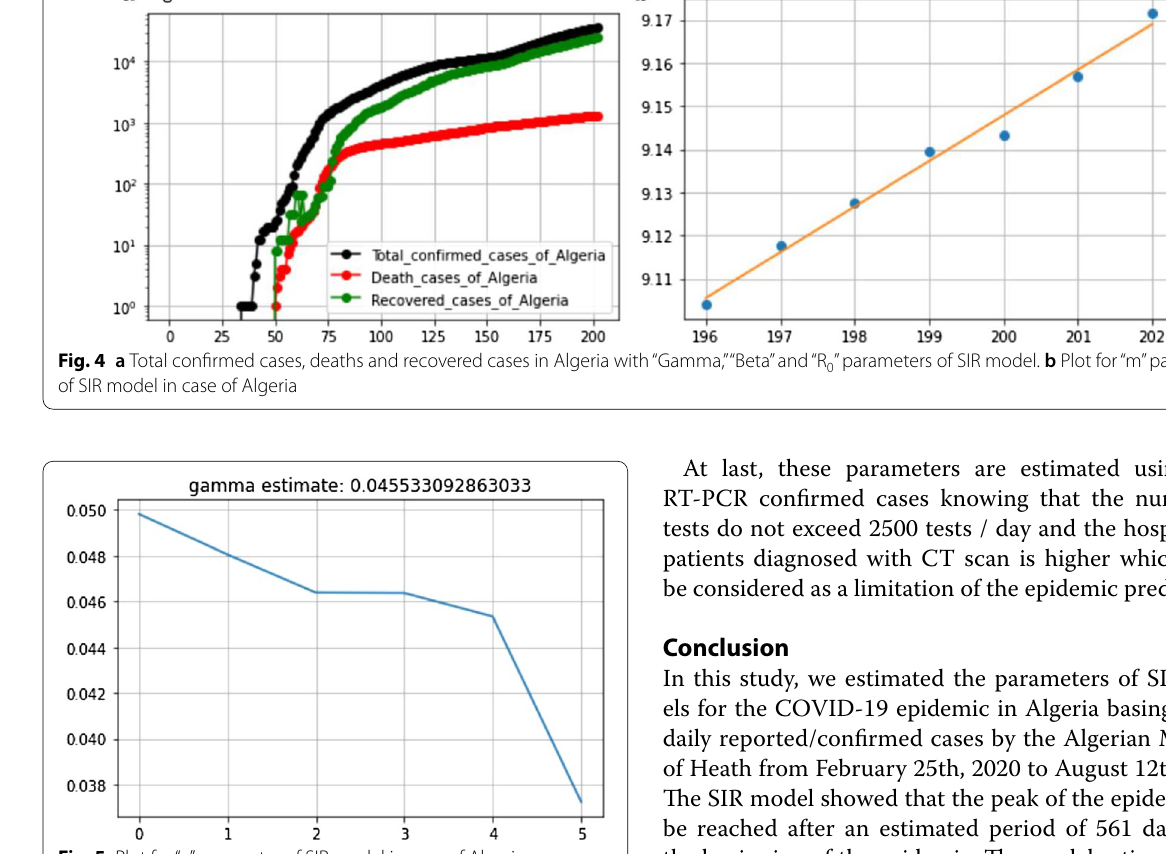
Fig. 5 Plot for “γ” parameter of SIR model in case of Algeria